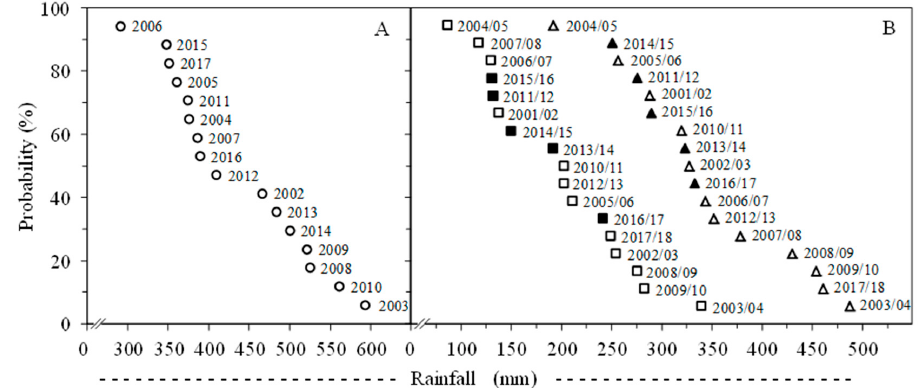
Figure 2. Annual ( A ) and seasonal ( B ) rainfall probability in the study area based on available rainfall data from the 2002–2017 period. In seasonal evaluation, the whole crop cycle (triangles) and the autumn–winter period (squares) are shown. In black: the years used in this work. Table 1. Maximum 24-h precipitation, for di ff erent return periods (years), at a regional scale calculated by di ff erent approaches.